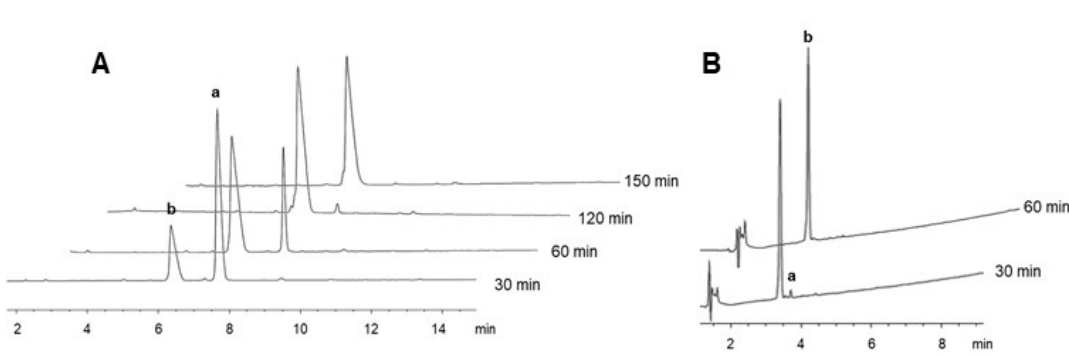
Figure 5. HPLC of the removal of the NO 2 group from H-Leu-Arg(NO 2 )-Phe-NH-Rinkamide-resin ( A ) and H-Asp(OtBu)-Phe-Gly-Arg(NO 2 )-Gly-NH-Rink-amide-resin ( B ) using 2 M SnCl 2 -0.04 M phenol-0.2 M aq HCl in 2-MeTHF at 55 ◦ C. a: protected peptide; b: unprotected peptide. Elution: 10-25% of B into A for ( A ) and 5-95% of B into A for ( B ) in 15 min.